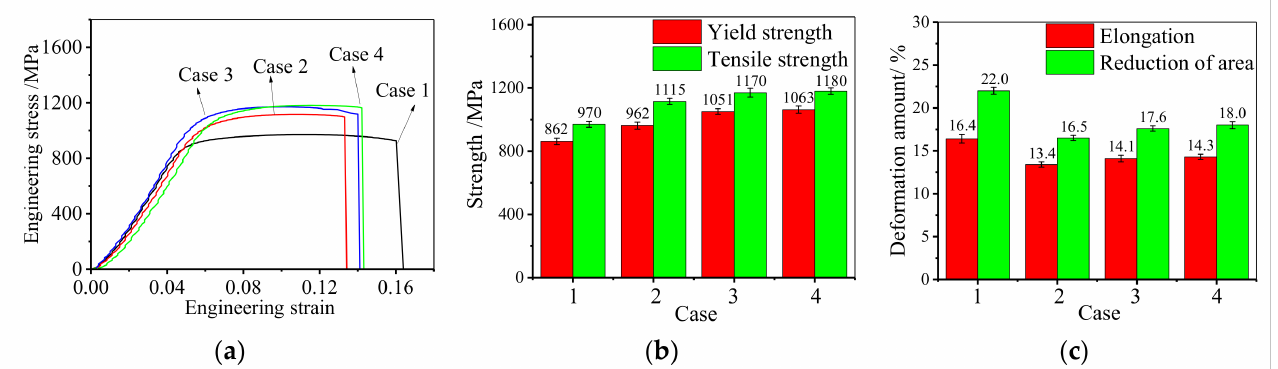
Figure 10. Effect of two types of annealing treatments on high-temperature tensile mechanical properties: ( a ) engineering stress–engineering strain curve; ( b ) strength; ( c ) elongation to fracture.